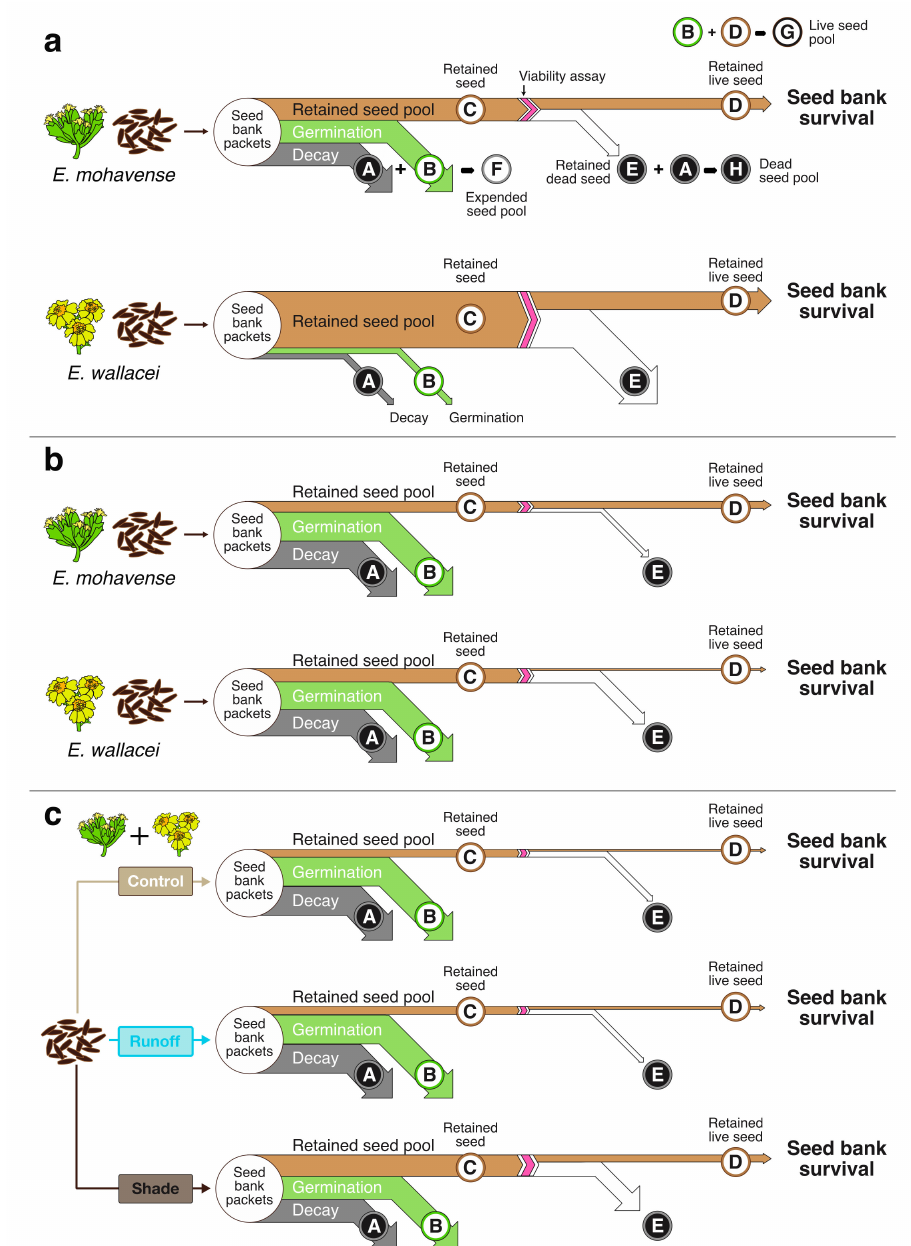
Figure 4. The seed bank survival model showing empirical seed bank pools and types for E. mohavense and E. wallacei. Models in ( a ) show flows for each species after one year of burial, with seed bank traits averaged across cohorts and microhabitats (we found no significant di ff erences in retained seed across microhabitats; see top row of panels in Figure S1). Models in ( b ) show flows for each species after two years of burial, with seed bank traits averaged across both cohorts and all microhabitats. Models in ( c ) show flows for Control, Runo ff , and Shade microhabitats averaged across both species and cohorts after two years of burial, when we observed higher seed retention in the Shade compared to the other two microhabitats (see bottom row of panels in Figure S1). We cannot confidently partition decayed seed (A) from germinated seed (B) in the expended seed pool (due to the delay between the winter annual germination period and collection of packets in spring), so we visualize these flows as equivalent in size. Flows exiting the staining assay (pink chevron) visualize the percentage of live seed for a subset of the retained seed pools (C) exposed to staining-based